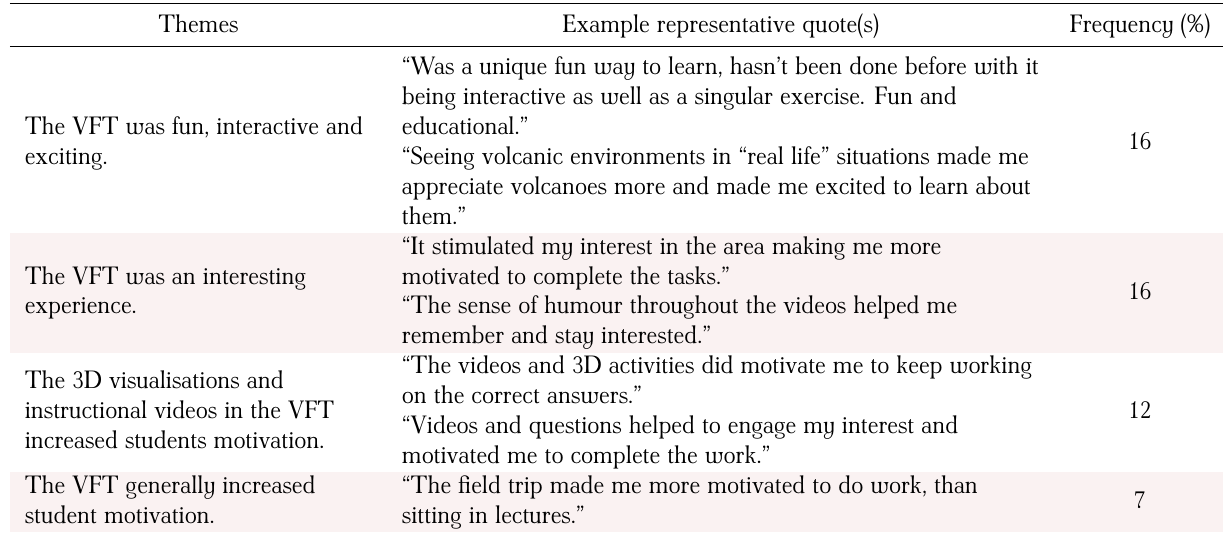
Table 2: Themes, example quotes, and frequency count of student answers to the motivation section of Q2 of the evaluation